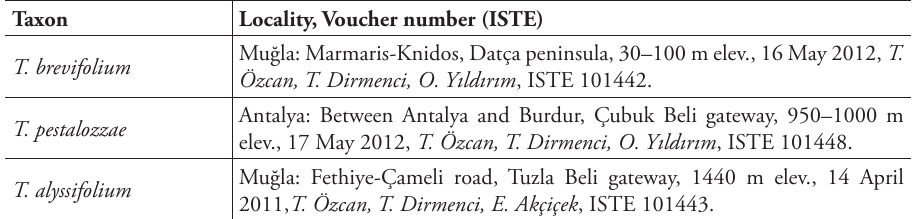
Table 1. Collection data of Teucrium taxa studied. Taxon Locality, Voucher number